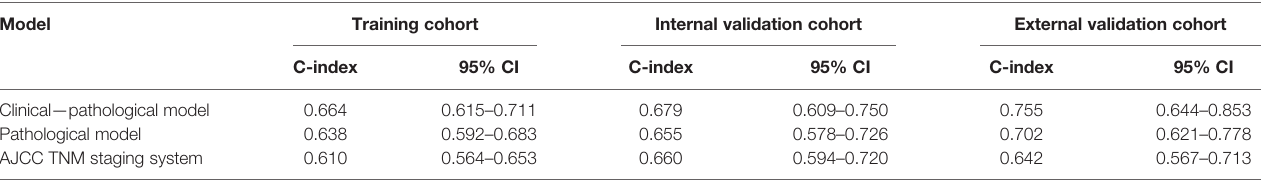
TABLE 3 | The C-indices for prediction of overall survival.